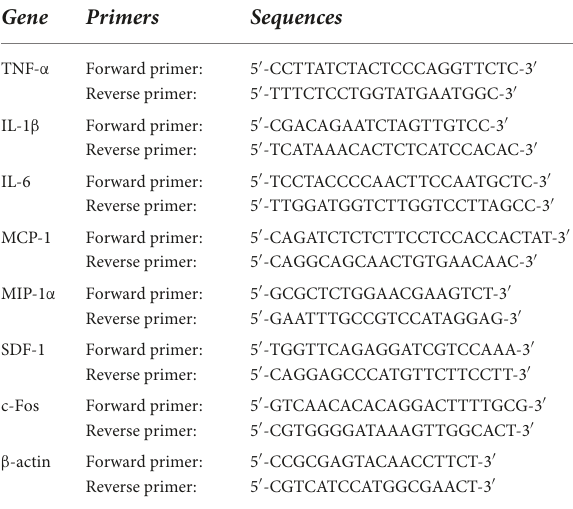
TABLE 1 Sequences for